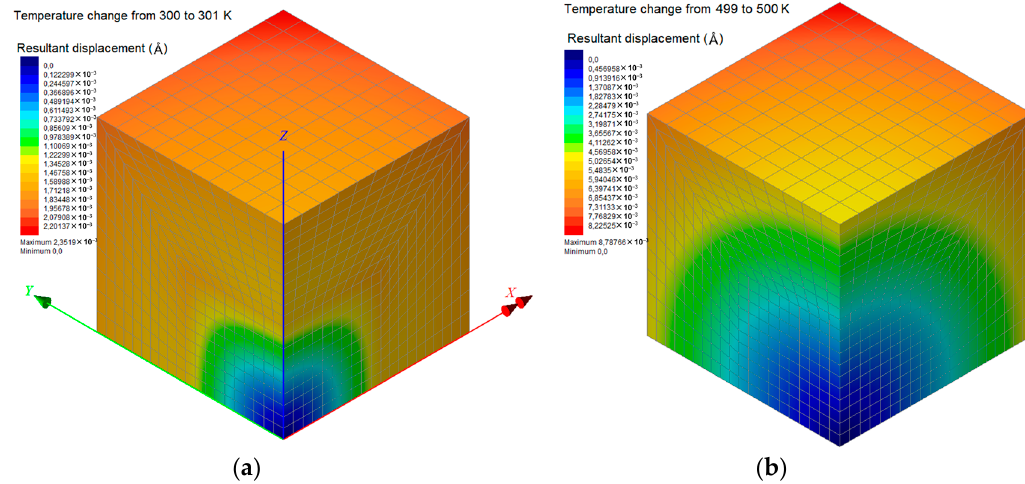
Figure 17. Contours of the resultant displacement of the nanocomposite RVE with a mass fraction with w C240 = 0.03, for a temperature change ( a ) from 300 to 301 K and ( b ) from 499 to 500 K.